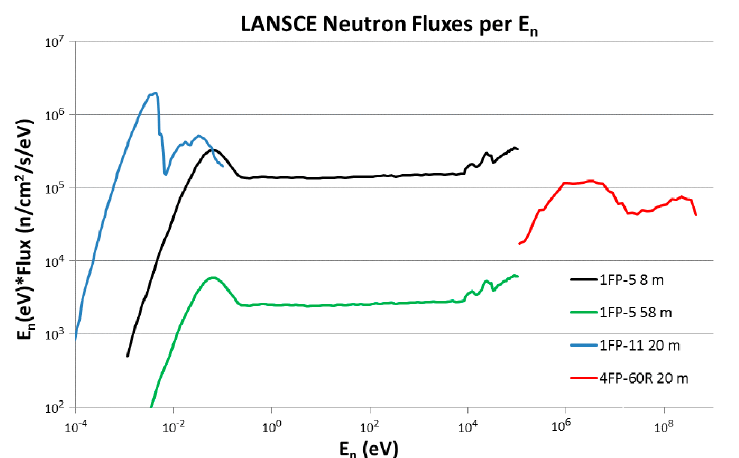
Figure 3. The neutron energy spectra for 1FP-05 at 8 m (black), 1FP-05 at 58 m (green) and 1FP-11 at 20 m (blue) at the Lujan Center and the 4FP-60R flux at 20 m at the WNR facility (red). The spectra were calculated and vetted with measurements for a proton beam current on Target 1 of 100 µA for the Lujan Center [37] and 4.0 µA at Target 4. (See text for details.).